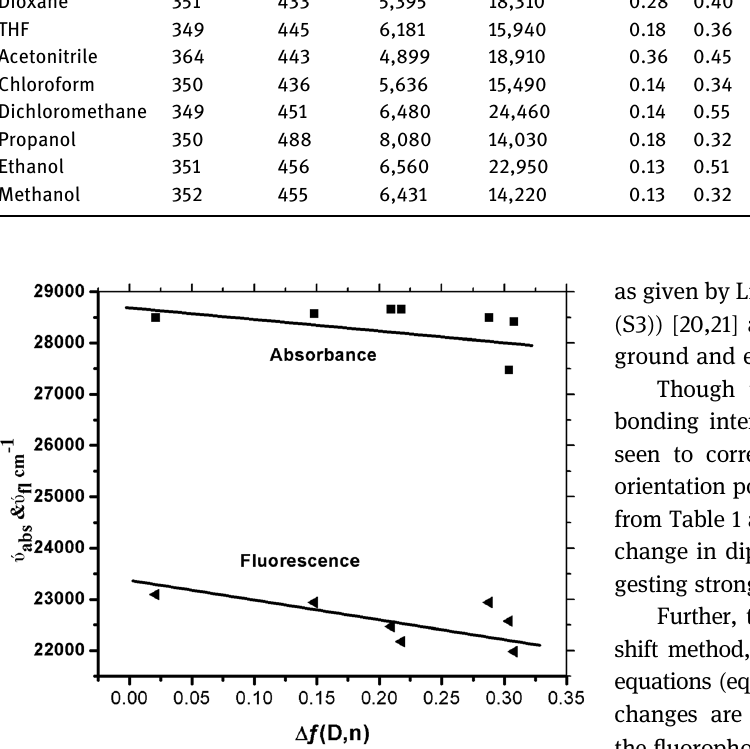
Figure 3: Plot of energy of absorption and emission ( cm − 1 ) vs Δ f of di ff erent